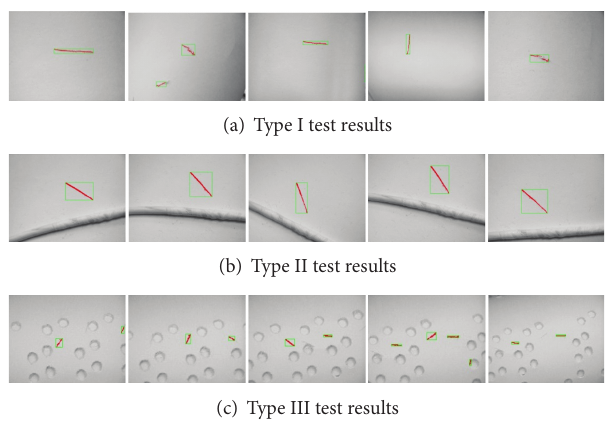
Figure 28: Image-processing test results to detect crack-like defects on different cable